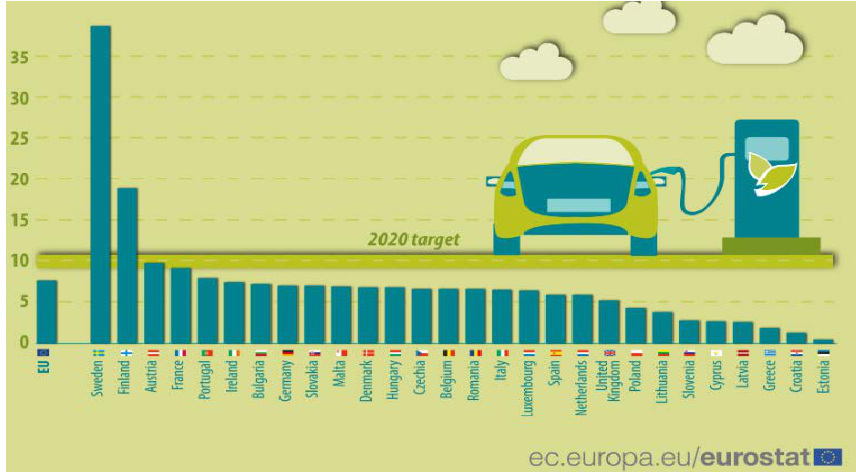
Figure 2: The share of the renewable energy use in transport, at EU level in 2017 Source: The European Commission,